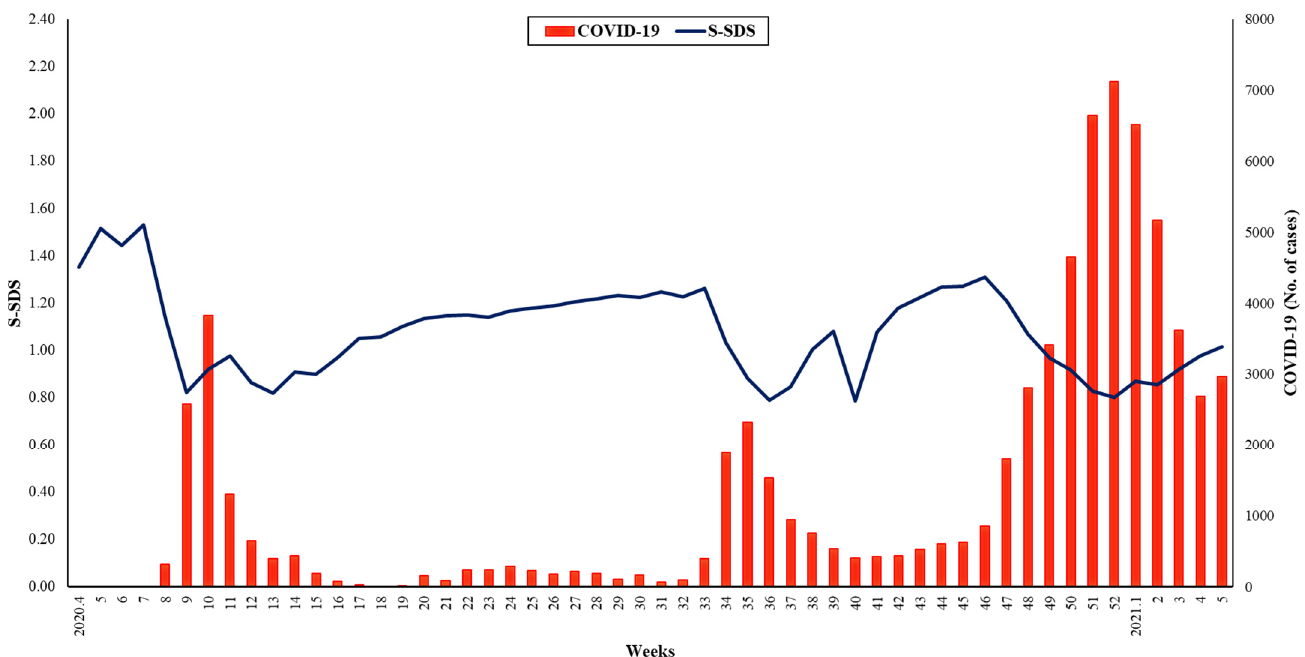
Figure 3. COVID-19 pandemic activity and S-SDS. COVID-19 cases were presented during study periods, between week 5 of 2020 and week 5 of 2021. The weekly trend of COVID-19 activity is shown as a bar graph and that of S-SDS is shown as a line graph. COVID-19, coronavirus disease 2019; S-SDS, subway use-based social distancing score.